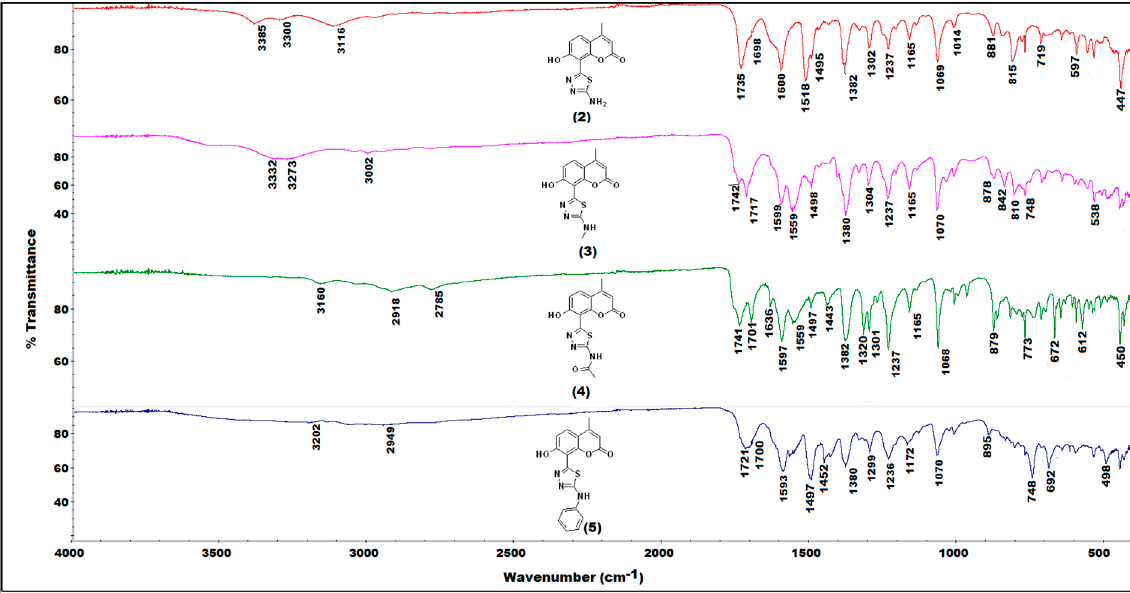
Figure 3. Comparison of IR (ATR) spectra of the coumarin-thiadiazole hybrids 2 – 5 .